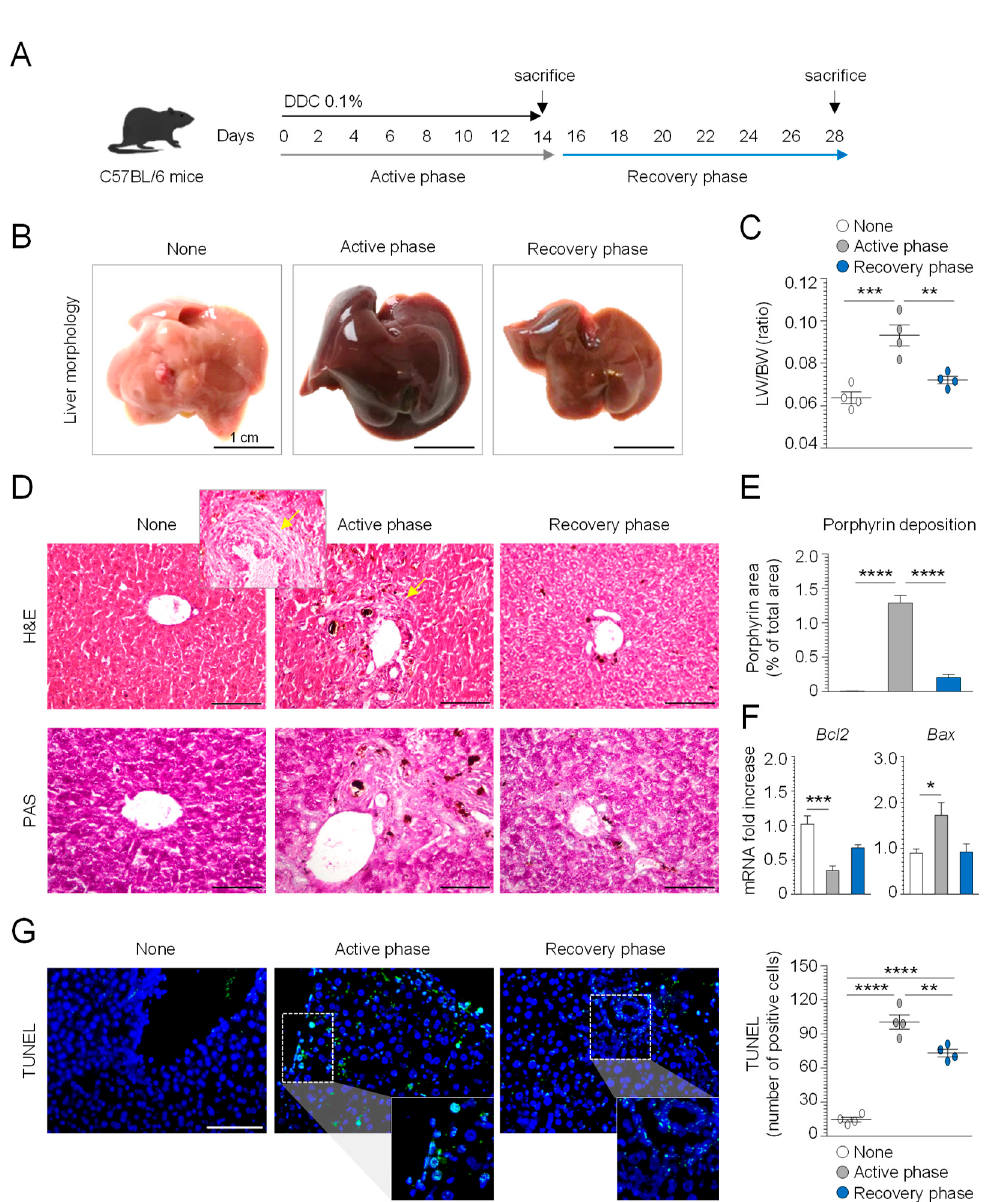
Figure 1. Characterization of the sclerosing cholangitis model in C57BL/6 mice. C57BL/6 mice were special diet containing 0.1% xenobiotic 3,5-diethoxycarbonyl-1,4-dihydrocollidine (DDC) (active phase) and subjected to a recovery time of 14 days (recovery phase), as depicted in the experimental schedule ( A ). The mice were sacrificed at different time points and evaluated for ( B ) liver gross histology, ( C ) liver (LW) and body weight (BW) ratio, ( D ) liver histopathology by Hematoxylin and Eosin (H&E), and Periodic Acid–Schiff (PAS) stains, ( E ) porphyrin deposition, ( F ) apoptotic marker expression by RT-PCR, and ( G ) TUNEL staining in the liver. Hoechst was used for nuclear counterstain in blue. Photographs were taken with a high-resolution microscope (Olympus BX51), 20 × magnification (scale bars, 200 µ m). The data are presented as the mean ± SEM and are representative of three experiments ( n = 4 mice/group). * p < 0.05, ** p < 0.01, *** p < 0.001, **** p < 0.0001, DDC-treated vs. untreated (none) mice, and active phase vs. recovery phase. One-way ANOVA, Bonferroni